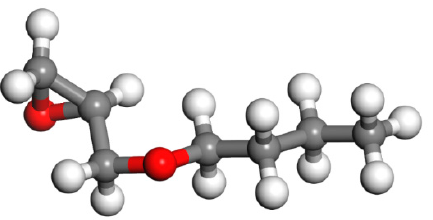
Figure 5. The model of TEPA (colour legend: hydrogen H (white); nitrogen N (blue); carbon C (grey)).